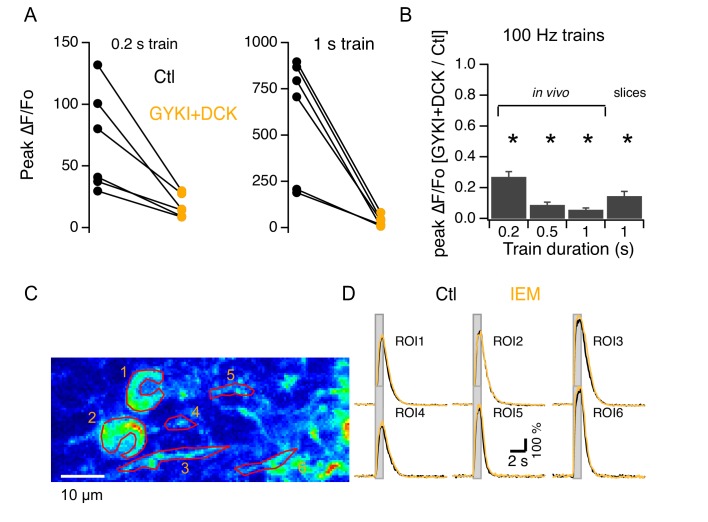
Synergy between iGluRs and mGluR1s in adult MLIs.(A) A mixture of 300 μM GYKI53655 and 100 μM DCK blocked somatic Cai rises under various PF stimulation protocols in vivo. (B) Ratios between peak amplitudes of ΔF/Fo in the blockers over control (n = 6 in each condition). (C,D) GCaMP3 imaging of PF-induced Cai rises in 2 somata and 4 putative neurites in vivo shows no difference between control (black traces) and addition of 40 μM IEM 1460 (yellow traces).